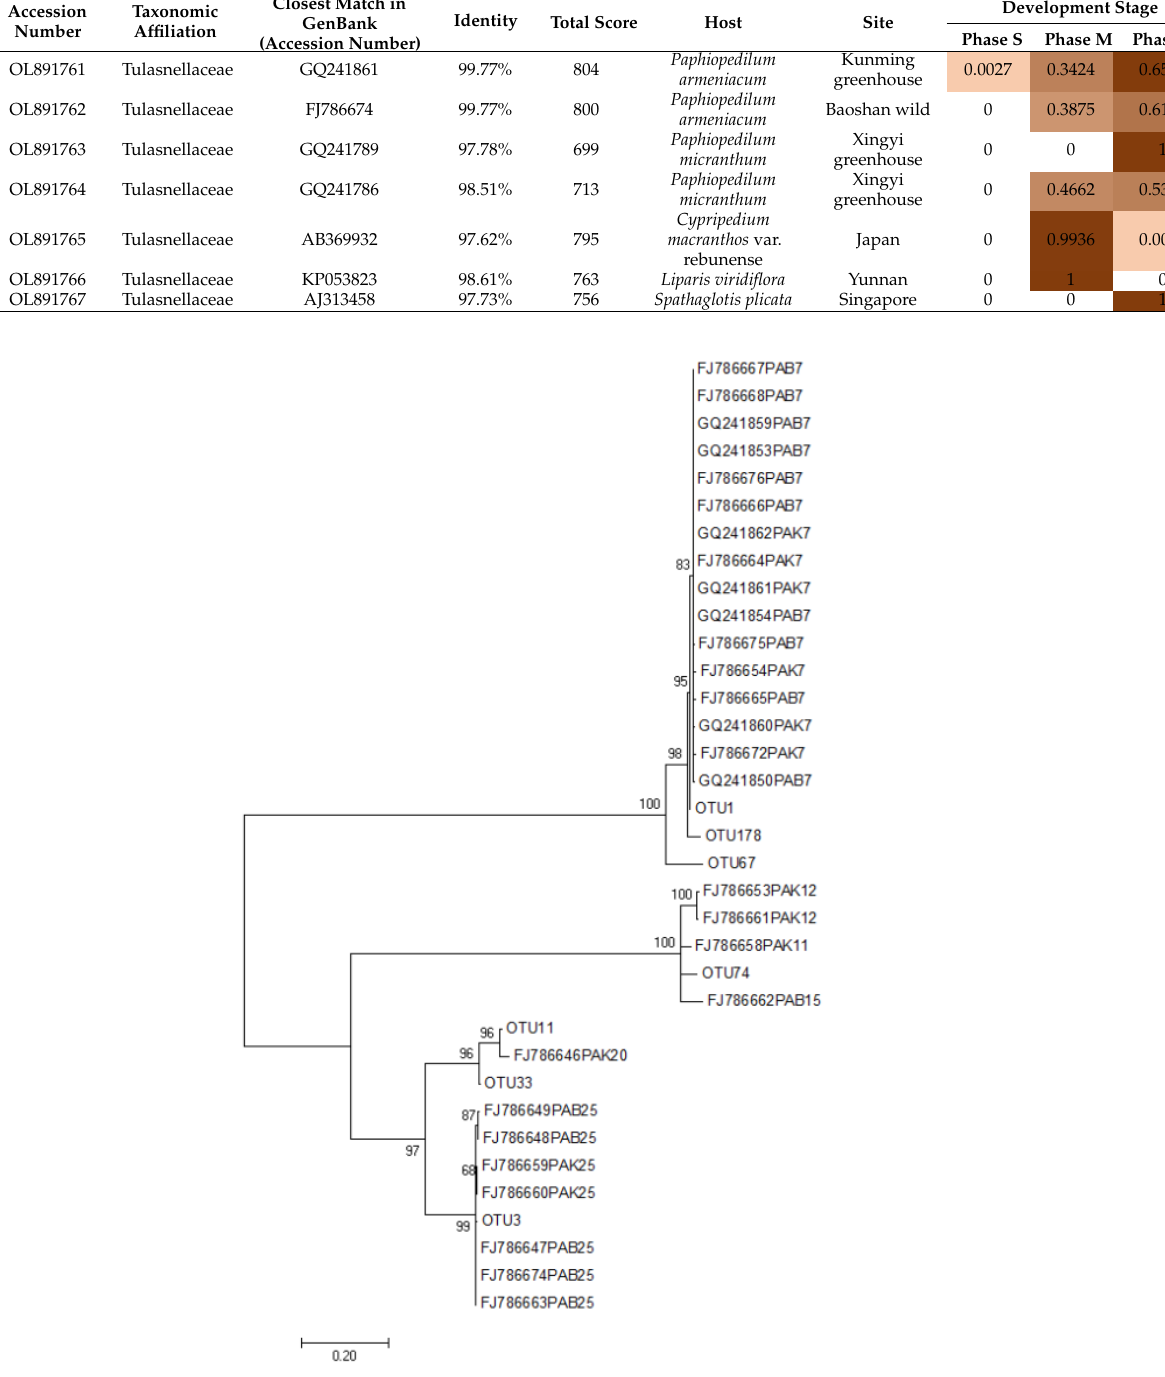
Figure 7. Maximum likelihood (ML) tree based on internal transcribed spacers (ITS) nuclear ribosomal DNA sequences of Tulasnellaceae fungi obtained from all samples and the GenBank database. Bootstrap (BS) values from 1000 replications in the ML analysis are indicated at the branches of the nodes. Scale bar is shown to infer evolutionary distances. PAB represent Paphiopedillum armeniacum from Baoshan (wild) ; PAK represents P. armeniacum from Kunming (greenhouse). The sequences with NCBI serial numbers are mycorrhizal fungi sequences obtained from P. armeniacum by Huang [14] and typing of the sequences.